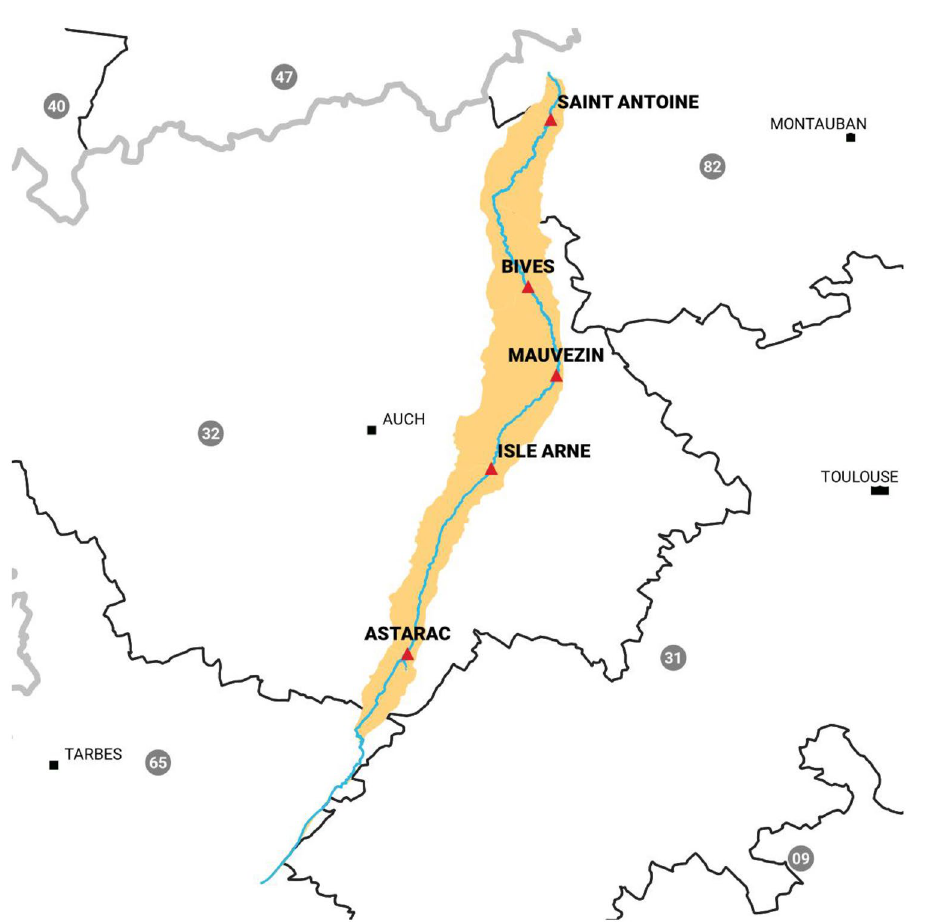
Figure 8. Map of the Arrats’ river and the hydrometric stations created with QGis version 3.16 (www. qgis.